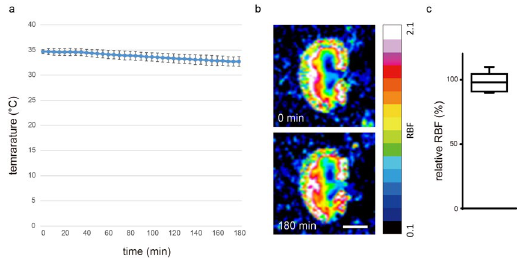
Figure 1. Confirmation of feasibility of long DTI MRI measurement with a special attachment. ( a ) Temperature changes in kidneys folded by the attachment during 180 min. ( b ) MR images of renal blood flow at 0 min (upper) and 180 min (lower) after setting of the attachment. ( c ) Quantification of relative renal blood flow based on the renal blood flow at 0 min. The data are shown as mean ±